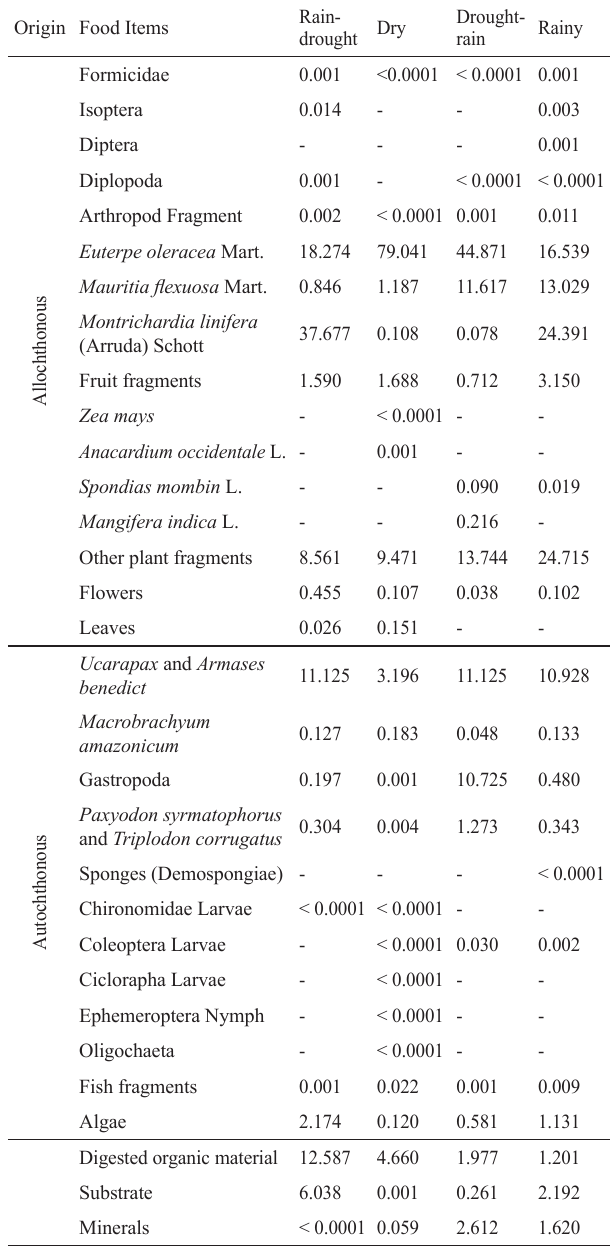
%) per pluviometric Table 3. Alimentary Index (AI i period of food resources consumed by the rock-bacu Lithodoras dorsalis on the rio Amazonas mouth region, Brazil. (-) Represents the absence of the food